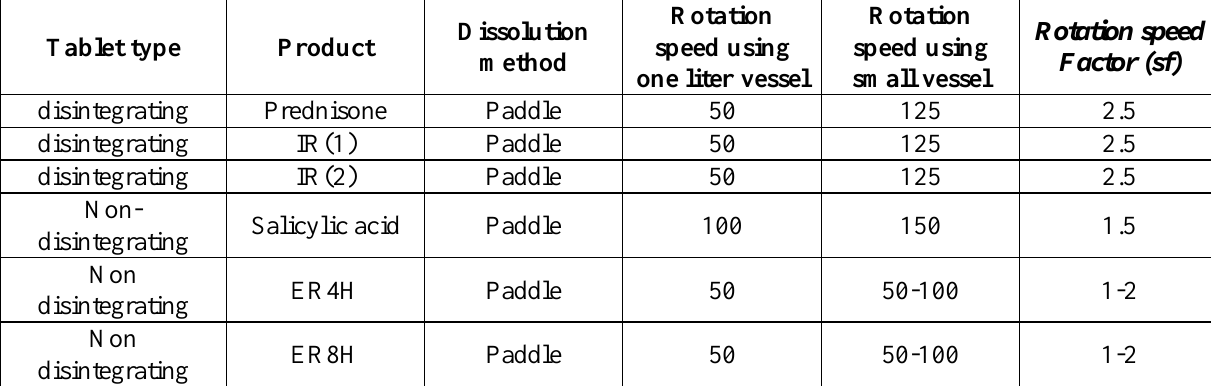
Table 4. Found rotation speed factors using small vessel versus one liter vessel to reach the same